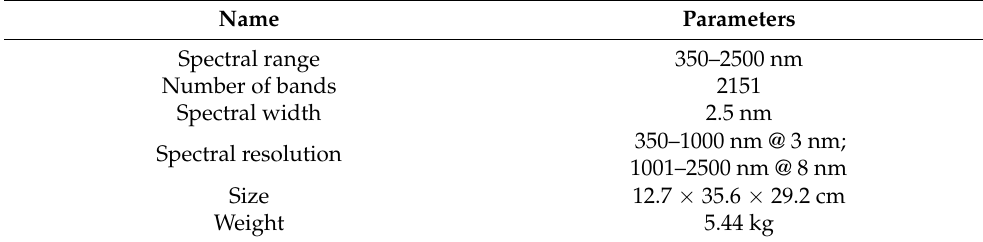
Table 1. Specifications of ASD FieldSpec 4 portable